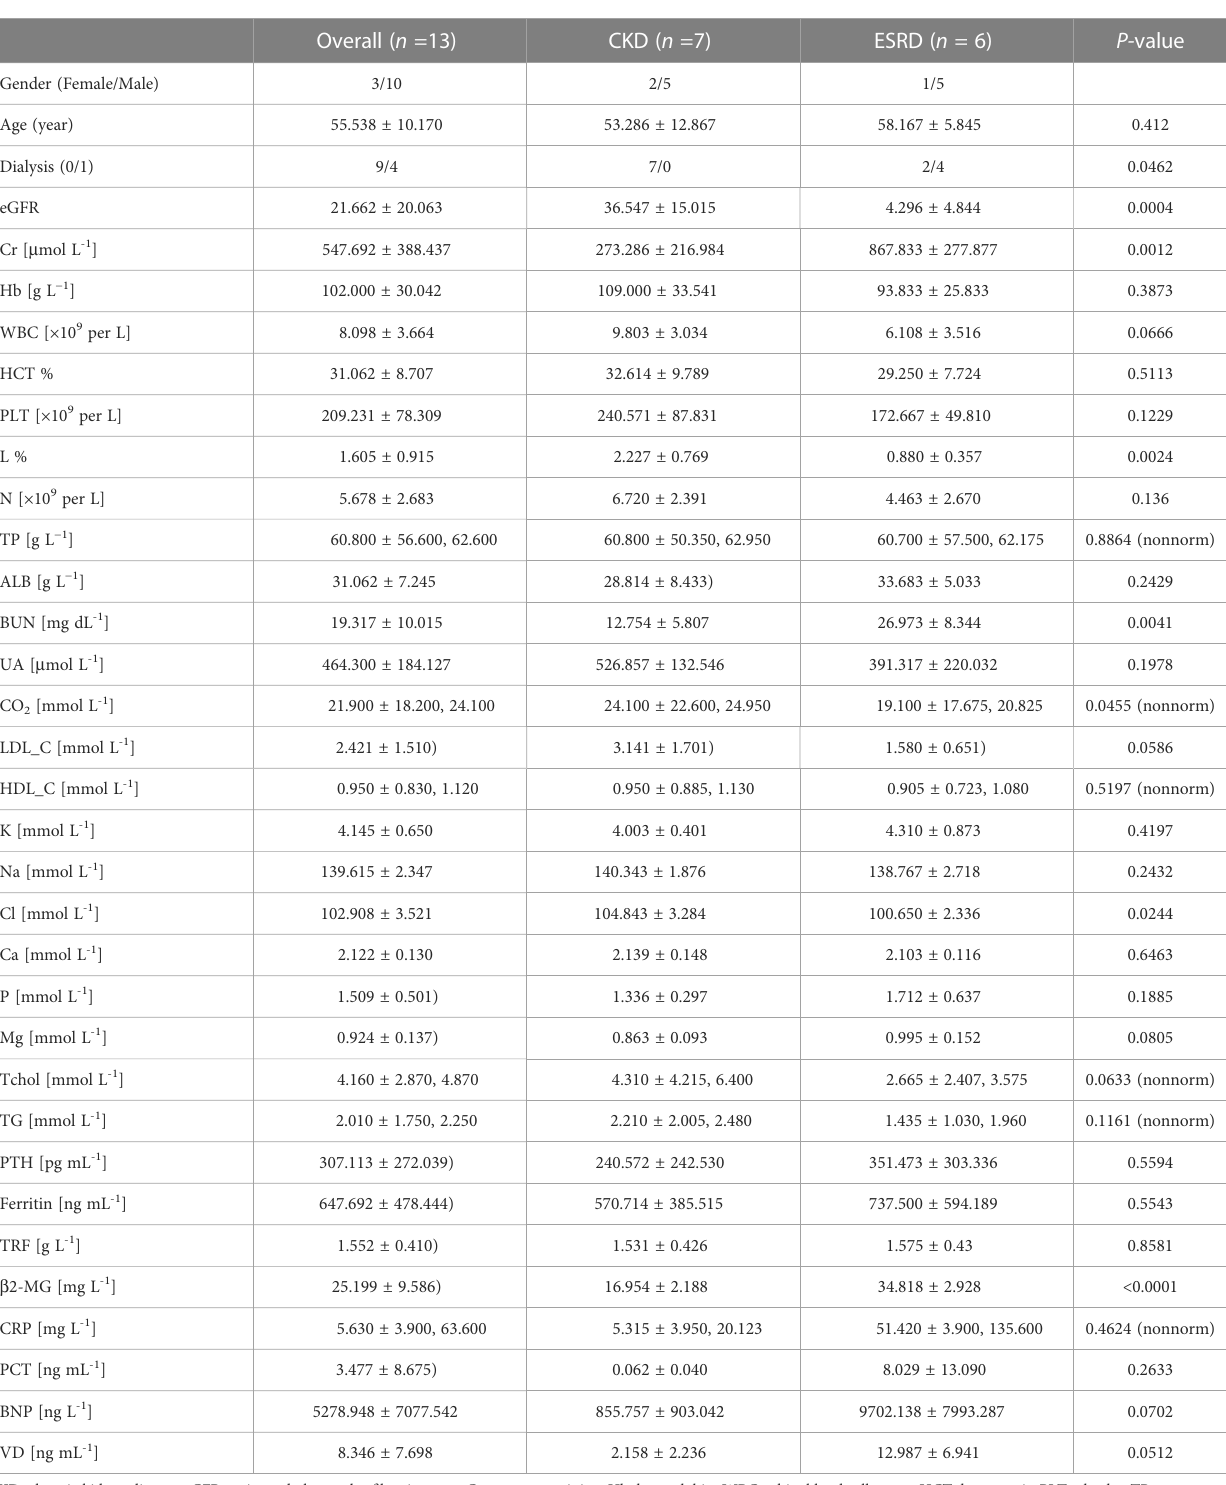
TABLE 1 Clinical indicators of patients in the CKD and ESRD